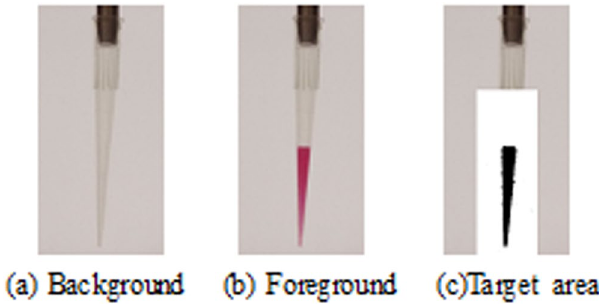
Figure 6. Liquid feature extraction effect map.